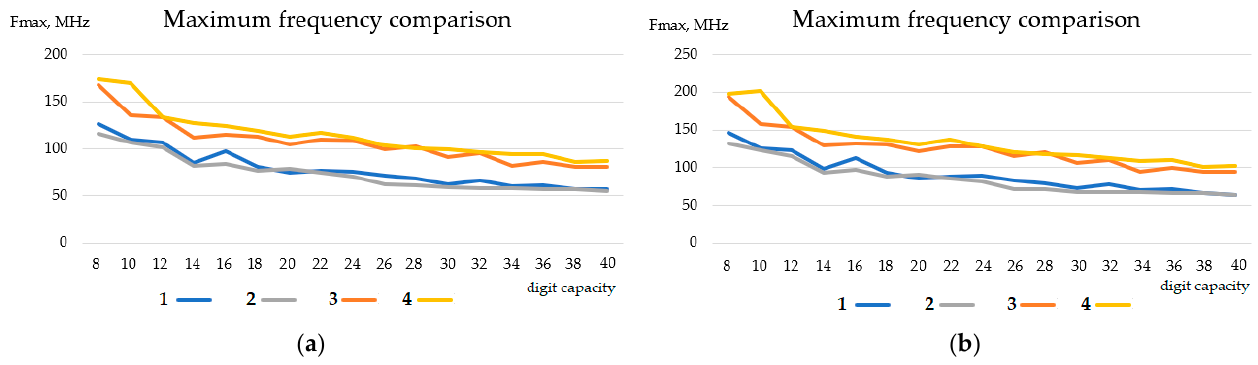
Figure 11. Maximum frequency of multiplier operation: ( a ) model Slow1, ( b ) model Slow2. The presented graphs were obtained for the following conditions: 1—multiplication of two arguments by Booth’s algorithm; 2—multiplication of two arguments by the proposed algorithm; 3— algorithm.